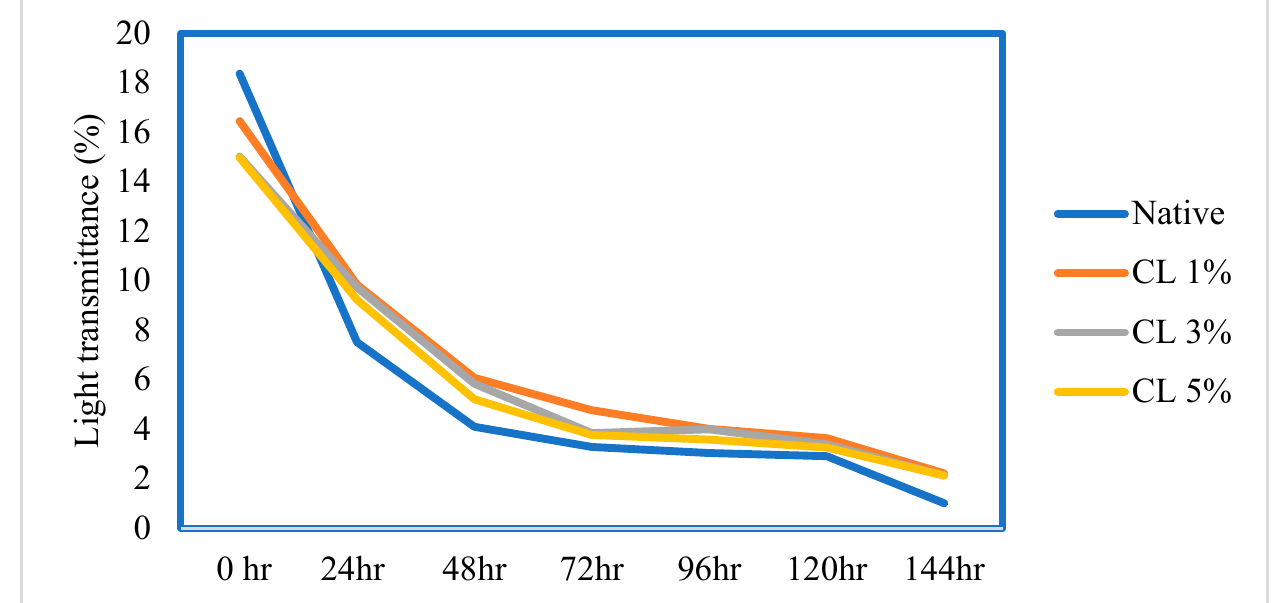
Figure 1. Effect of storage duration on the transmittance (%) of native and cross-linked (CL) lotus seed